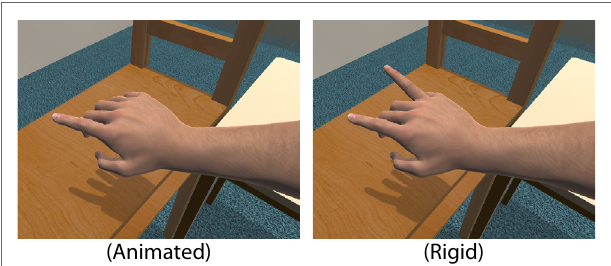
FigUre 2 | example pose of the six-digit virtual hand in the animated (left) and rigid (right) conditions . In the Animated condition all the six digits were animated as specified in Section 2, while in the Rigid condition the additional virtual digit was non-responsive to the users’ movements as if it was a dead and rigid finger fixed in relation to the